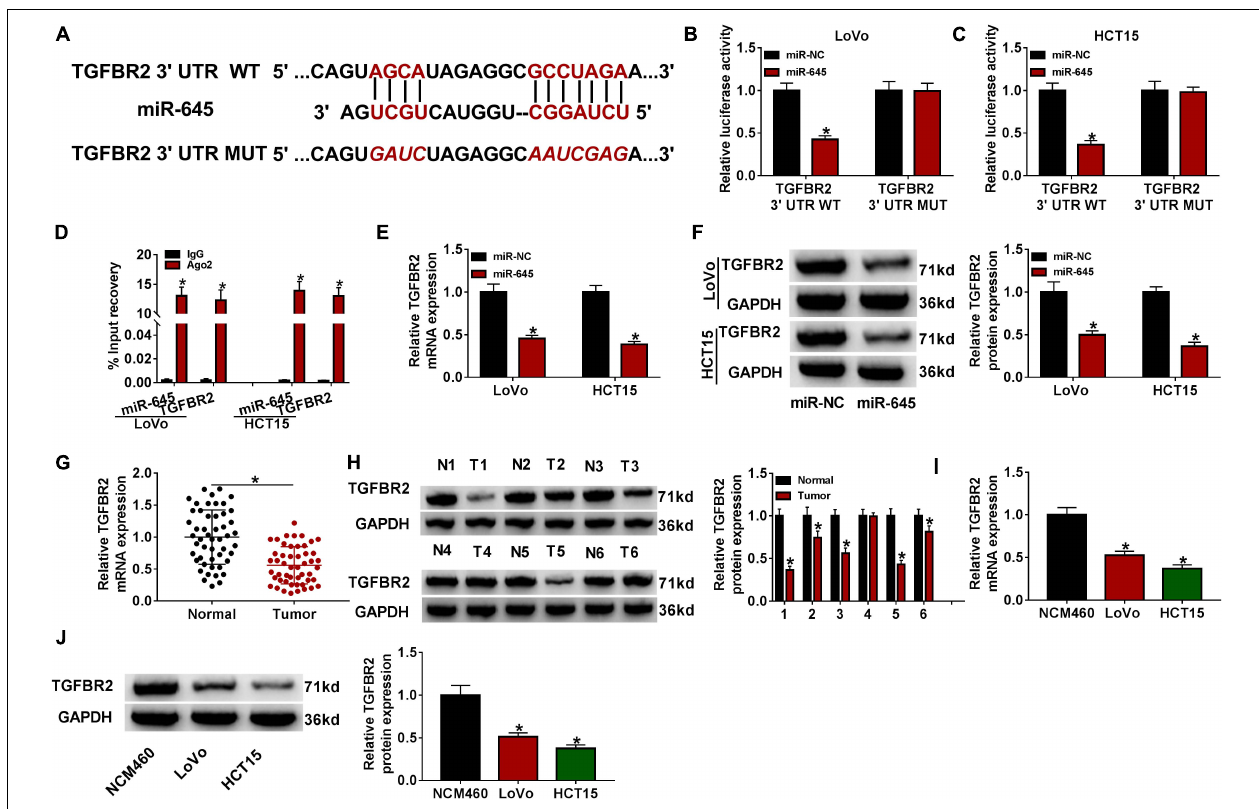
FIGURE 5 | TGFBR2 was a target of miR-645. (A) Wild-type TGFBR2 3 (cid:48) UTR sequence containing miR-645 binding sites was mutated to generate mutant-type TGFBR2 3 (cid:48) UTR sequence for dual-luciferase reporter assay. (B,C) Dual-luciferase reporter assay was conducted to verify the interaction between miR-645 and TGFBR2. (D) RIP assay was conducted to verify the interaction between miR-645 and TGFBR2. (E,F) The expression of TGFBR2 suppressed by miR-645 restoration was detected by qRT-PCR and western blot. (G,H) The expression of TGFBR2 in tumor tissues ( n = 50) and normal tissues ( n = 50) was detected by qRT-PCR and western blot. (I,J) The expression of TGFBR2 in LoVo, HCT15 and NCM460 cells was detected by qRT-PCR and western blot. * P < 0.05.